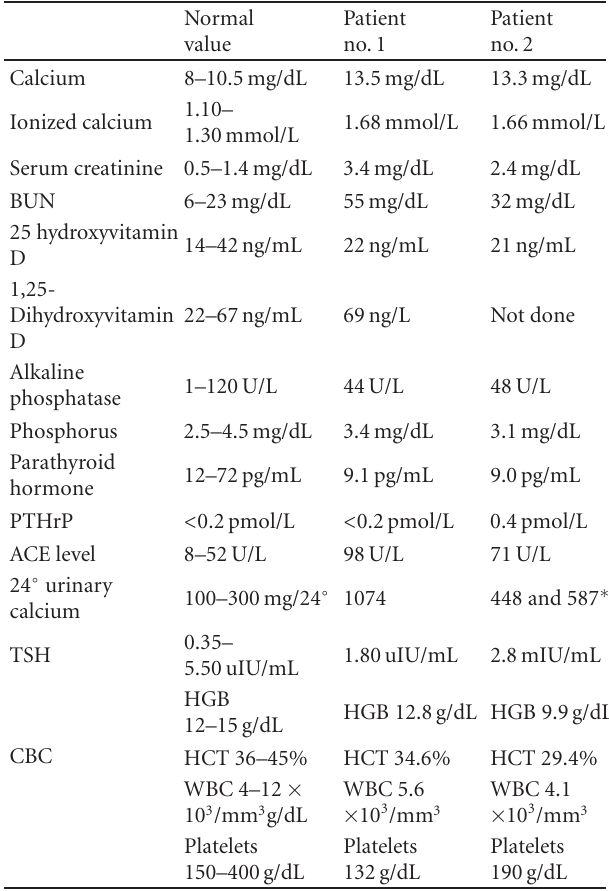
Table 1: Laboratory values of patients 1 and